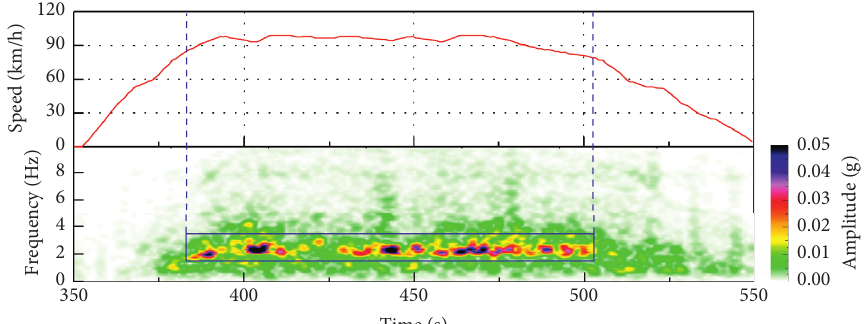
Figure 3: Time-frequency diagram about carbody and speed of vehicle